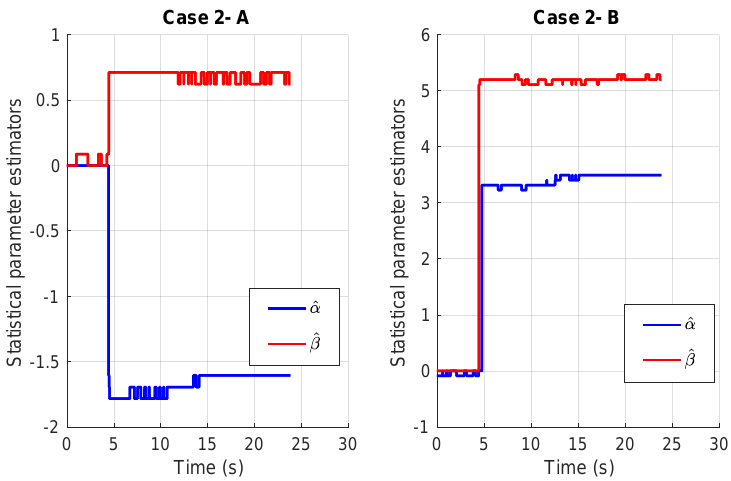
Figure 11. Case 2: Time evolution of the likelihood estimation of the parameters ˆ α and ˆ β . Case 2-A shows, at approximately 14 s, that parameter ˆ α detected a change in soil